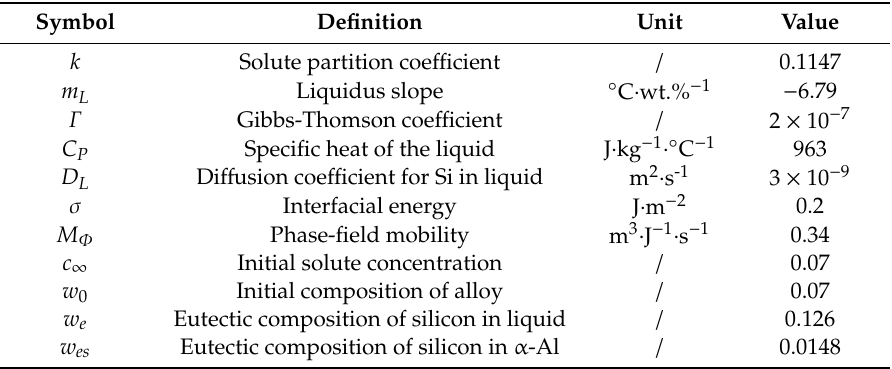
Figure 2. ( a ) Relationship between fraction solid and temperature, and ( b ) phase diagram for aluminum alloy 357.0. Table 1. Thermodynamic and kinetic parameters of aluminium alloy 357.0.